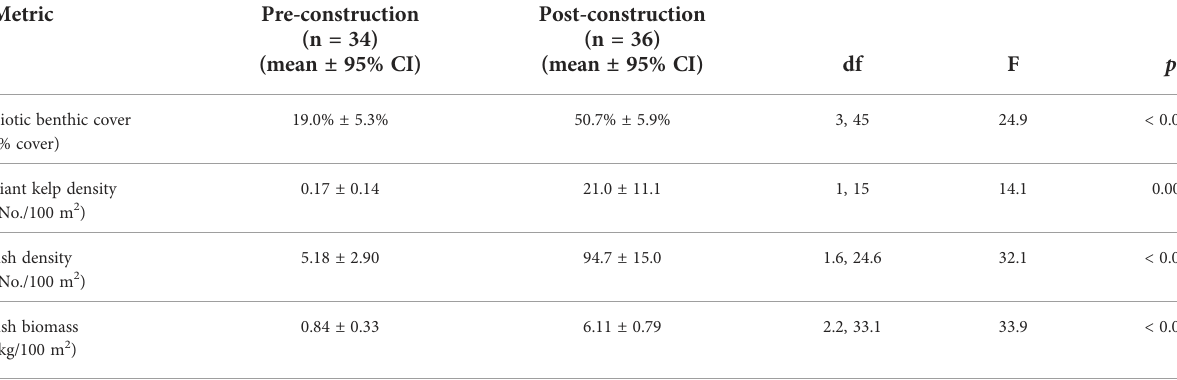
(Figure 7B), values from each post-construction survey were signi fi cantly higher than either pre-construction survey ( p < 0.001), and values were not signi fi cantly different between post- construction surveys ( p = 0.125 – 0.187). Giant kelp density in the 2021 post-construction survey was signi fi cantly higher than in each TABLE 2 Mean values ± 95% CI for pooled pre- and post-construction metrics with repeated measures ANOVA results.